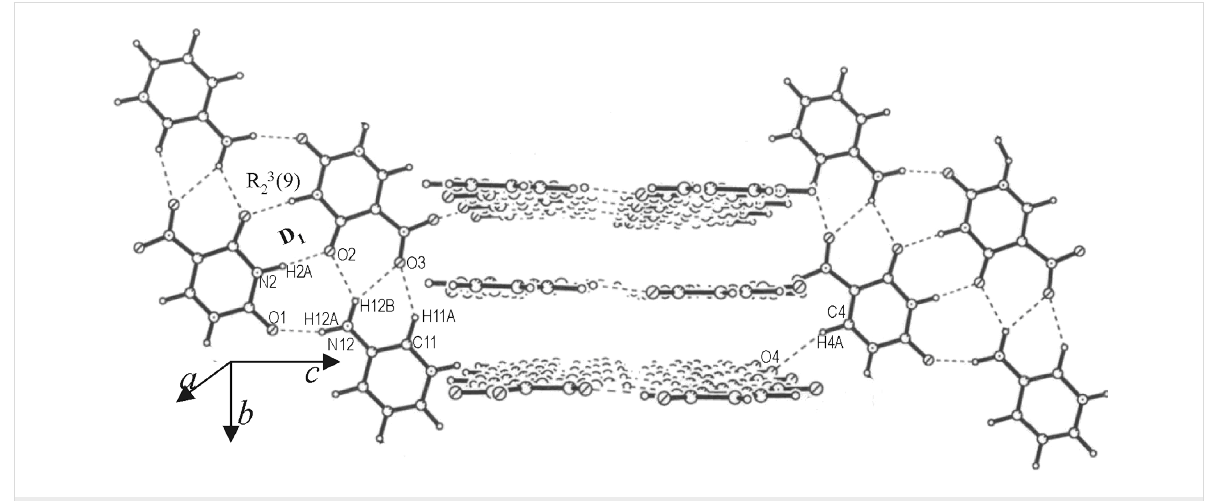
Figure 7: Cocrystal of I and 3-aminopyridine: Stacks of molecular tapes arranged in alternating parallel and perpendicular orientations.